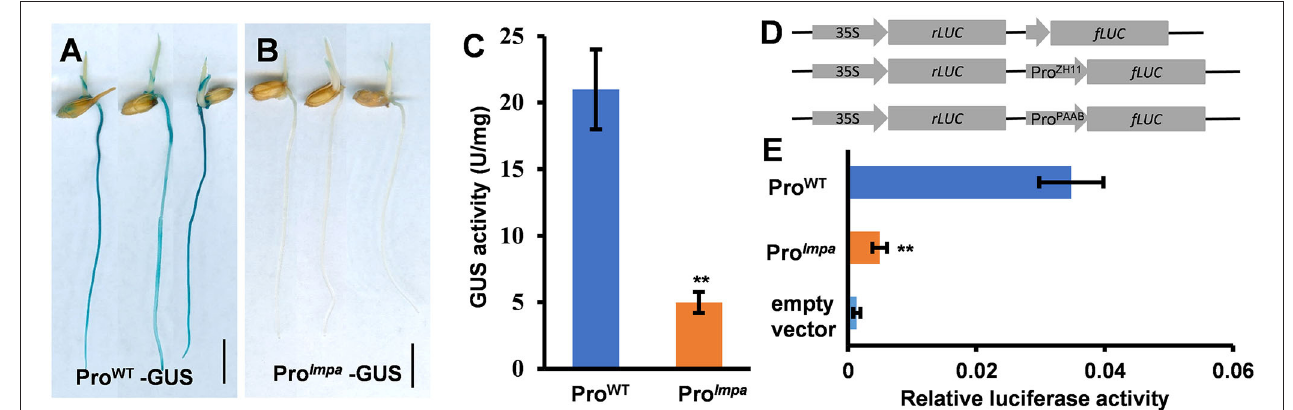
FIGURE 6 | Promoter activity analysis. (A,B) GUS staining of Pro WT -GUS and Pro lmpa –GUS transgenic plants. (C) The GUS activity in WT and lmpa roots at the seedling stage. (D,E) Transient expression assays of the WT promoter and lmpa promoter. Error bars represent standard deviation (SD) ( n = 3); **Significant difference at p < 0.01 compared with the WT by Student’s t -test. Bars = 1cm in (A,B)